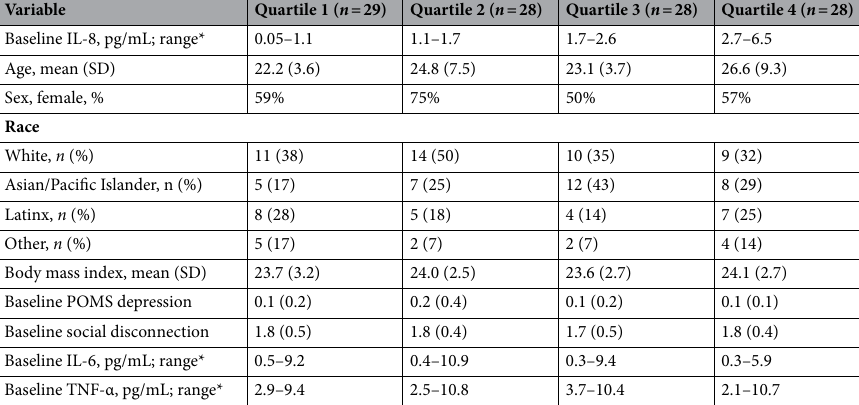
Table 2. Baseline characteristics of the sample stratified by baseline IL-8 quartile. *Values were transformed by natural logarithm before all statistical analyses, but raw data are presented